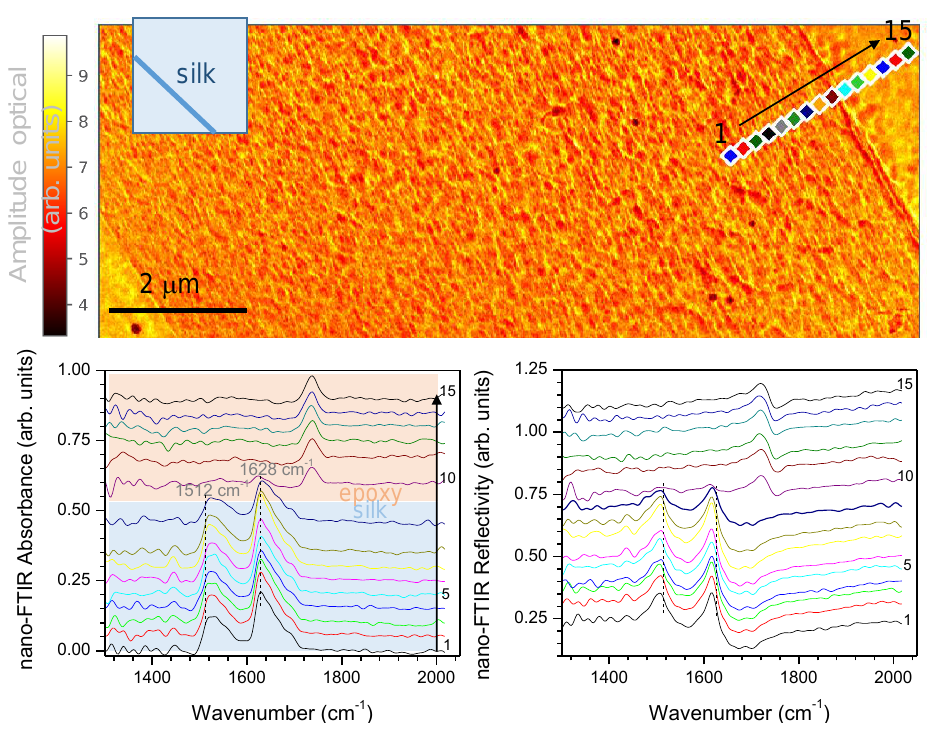
Figure 3. Scattering SNOM mapping and point spectra at 15 locations separated on a line by 200 nm (color marked) measured on the longitudinal slice. The amplitude and phase of the measured spectra.